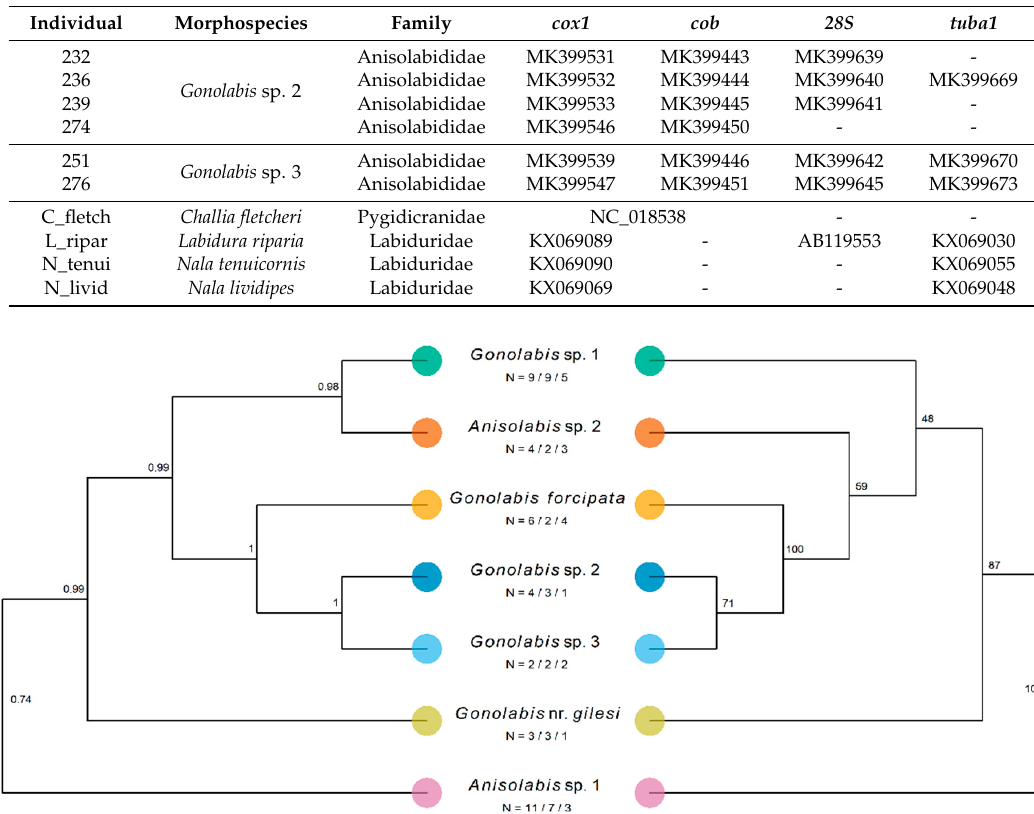
Figure 4. Results of Bayesian and maximum-likelihood phylogenetic analysis estimating the species tree of the Anisolabididae morphospecies. Labels under species names represent the number of individuals of that morphospecies from which sequences of a combined mitochondrial fragment of cytochrome c oxidase subunit 1 (658 bp) and cytochrome b (358 bp) (1016 bp), a fragment of 28s ribosomal DNA ( 28S ) (442 bp), and the tubulin alpha-1 gene ( tuba1 ) (468 bp) were obtained. Trees were rooted using members of the Labiduridae family, but these were pruned for visualisation. Left: Maximum clade credibility species tree of Anisolabididae morphospecies estimated using *BEAST, a Bayesian reconstruction of the multi-species coalescent of the individual genes. Node labels indicate posterior probability. 95% HPDI of tree likelihood = [ − 7949.638, − 7421.390], mean tree likelihood = − 7446.813. Right: Maximum likelihood tree for a concatenated dataset of fragments of the mitochondrial ( cox1 + cob ), 28S , and tuba1 sequence data inferred using RAxML with a general time-reversible model of sequence evolution with a gamma-distributed rate parameter. Model parameters were estimated separately for each fragment using a partition. Node labels show bootstrap support from 1000 bootstraps using RAxML’s rapid bootstrapping algorithm. Tree likelihood = − 8205.895. NB: While *BEAST estimates a species tree with as many leaves as taxa considering each gene tree separately, RAxML reconstructs a tree using the whole concatenated dataset, and infers the topological placement of all individuals. As all morphospecies except G . sp. 3 formed clades with 100% bootstrap support, these have been collapsed for comparison with the *BEAST species tree such that the ML tree only shows morphospecies and not individuals.